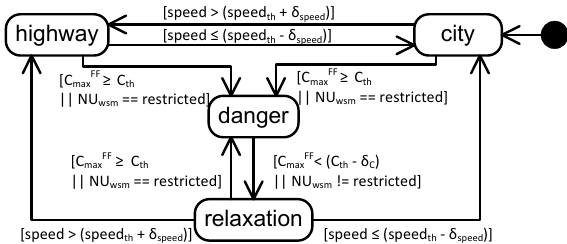
Figure 5: Driving State FSM responsible for adjust- ing A